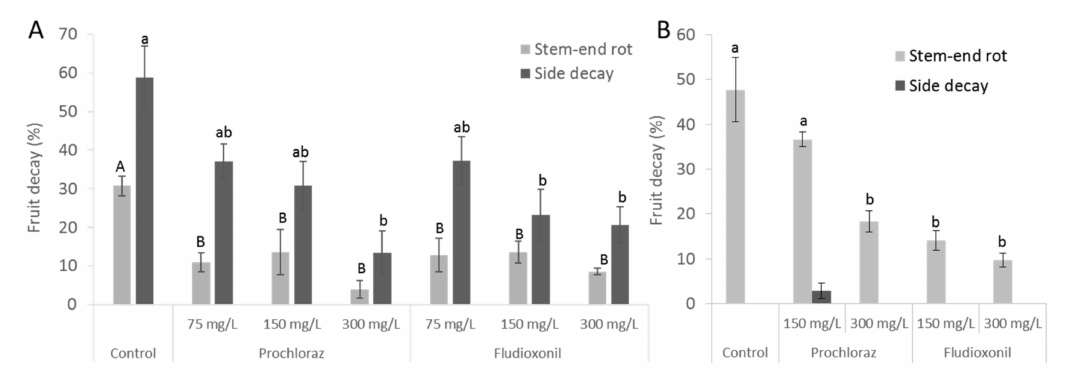
Figure 2. Postharvest fungicide application on avocado fruit and its e ff ect on natural stem-end rot. The fruit was treated with prochloraz or fludioxonil at di ff erent concentrations (300, 150, 75 mg / L); then, the fruit was stored at 5 ◦ C for 21 days and for additional shelf life storage period (SL) at 20 ◦ C for 7 days. At the end of the experiment, the stem-end rot and side decay incidence were determined. ( A ) “Reed” fruit from Nahshonim, Israel, 2018. ( B ) “Ettinger” fruit from Magal, Israel, 2015. Presented values are average and SE. Di ff erent letters indicate a significant di ff erence ( p < 0.05) by one-way